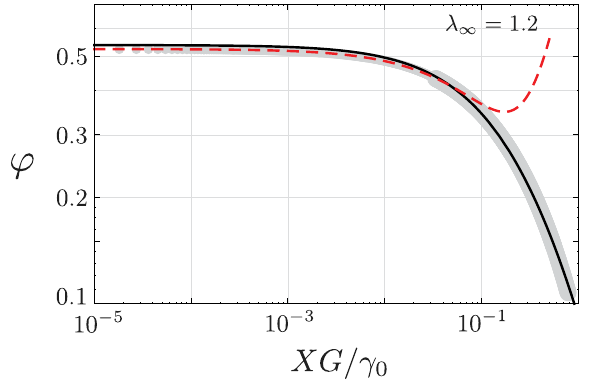
8. Typical example of the approach of the Neumann angle: the interface angle φ with respect to the horizontal as a function of the scaled distance to the contact line rG= γ . Light gray symbols correspond to FEM without a Shuttleworth effect ( c 0 ¼ c 1 ¼ 0 , with γ 0 ¼ γ ); large symbols represent a typical range acces- LV sible to experiments. The red dashed line gives the asymptotics (A1), while the solid black line (A2) gives an improved fit at the scale r ∼ γ =G . The latter is fitted over the range typically accessible in experiment (large symbols, appearing as a thick gray